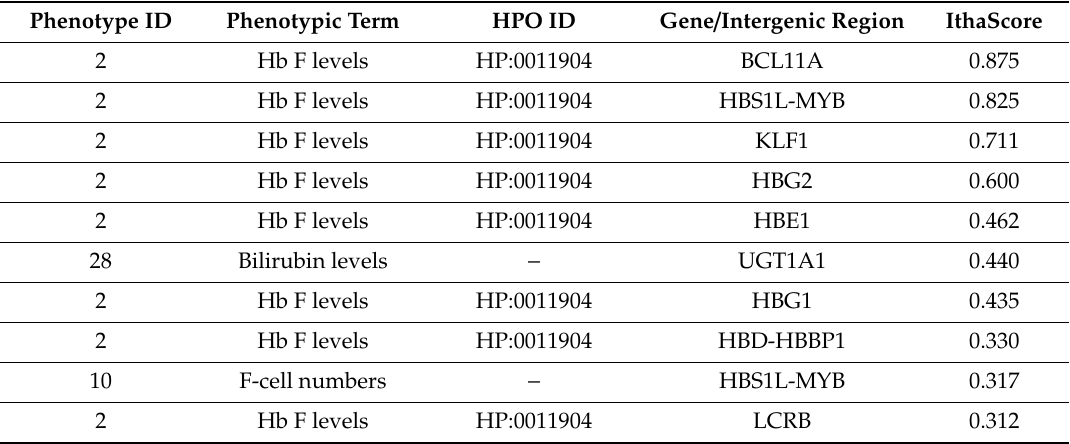
Table 3. Top 10 gene-phenotype interactions with the highest IthaScore. “Phenotype ID” column represents the identifier assigned to each phenotype throughout this